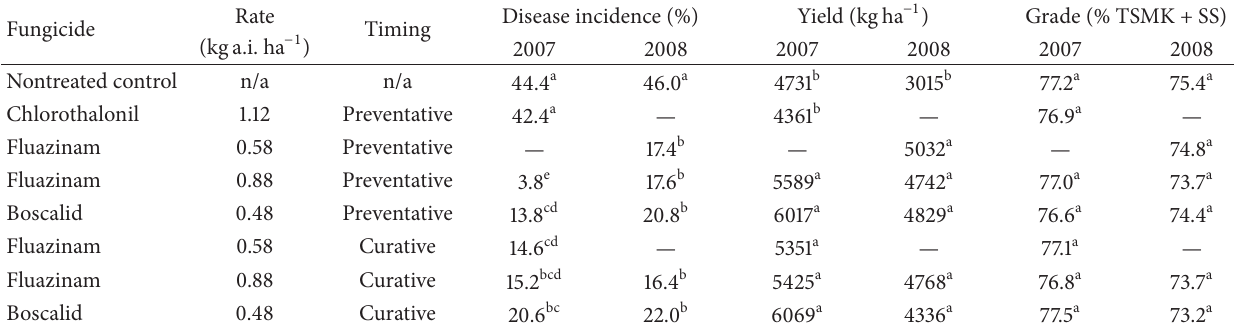
Table 2: Comparison of fluazinam and boscalid fungicide programs applied prior to observing symptoms of Sclerotinia blight in peanut and after disease onset a .